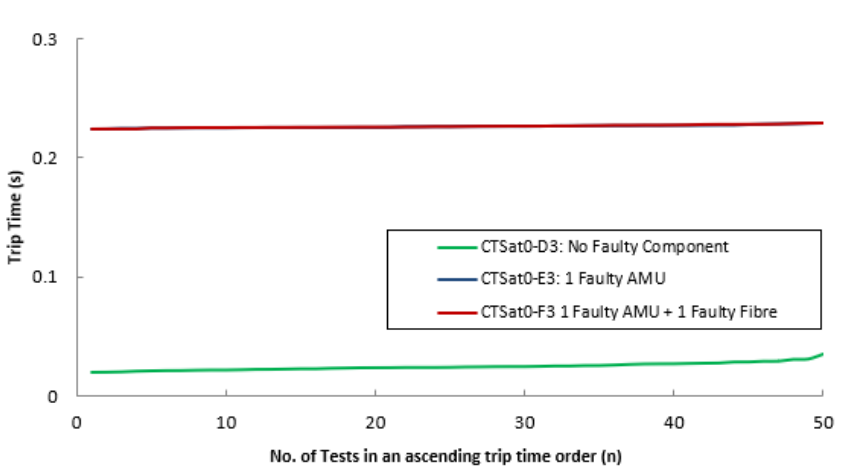
Figure 31. Comparisons for CTSat0-D3, CTSat0-E3 and CTSat0-F3 (ideal CT, L-L-G fault at 100% of the feeder).